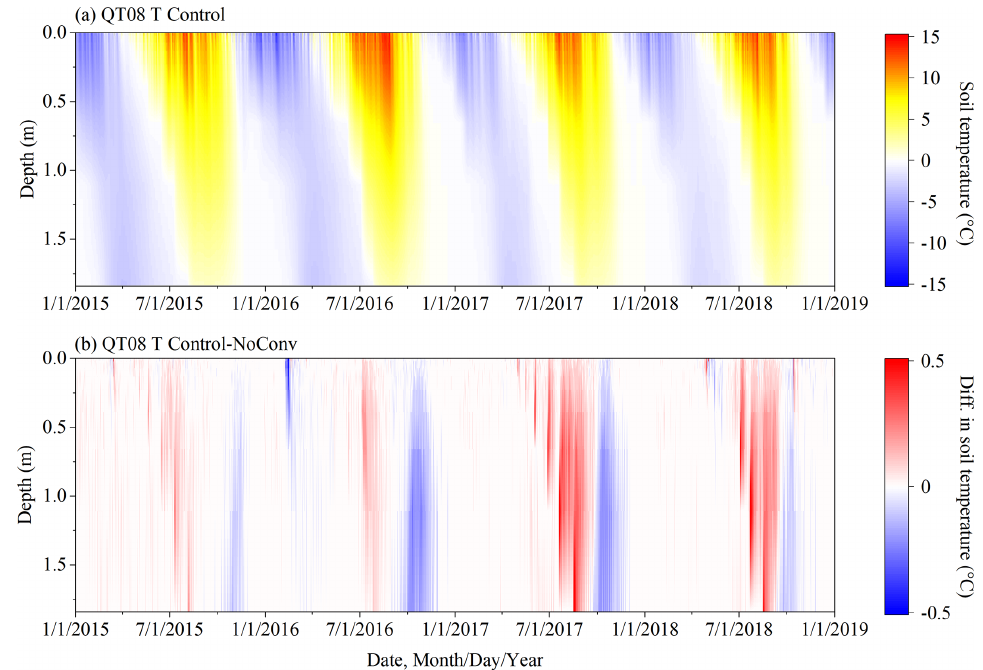
Figure A1. Simulated ground temperature profiles at QT08 under the Control scenario (a) , as well as the differences in simulated soil temperature between the Control and NoConv scenarios (Control–NoConv) (b) . Control and NoConv represent the scenarios with full and no consideration of convective heat transfer (CHT) in the SHAW model, respectively. Note that this figure has a different scale than Fig. 4.